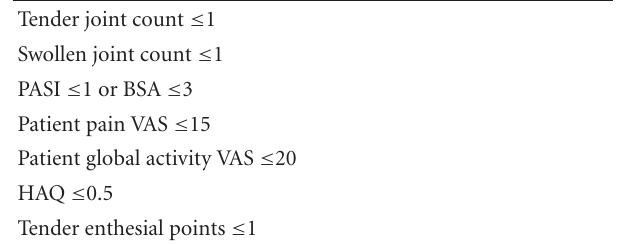
Table 3: Minimal disease activity (MDA) criteria in psoriatic